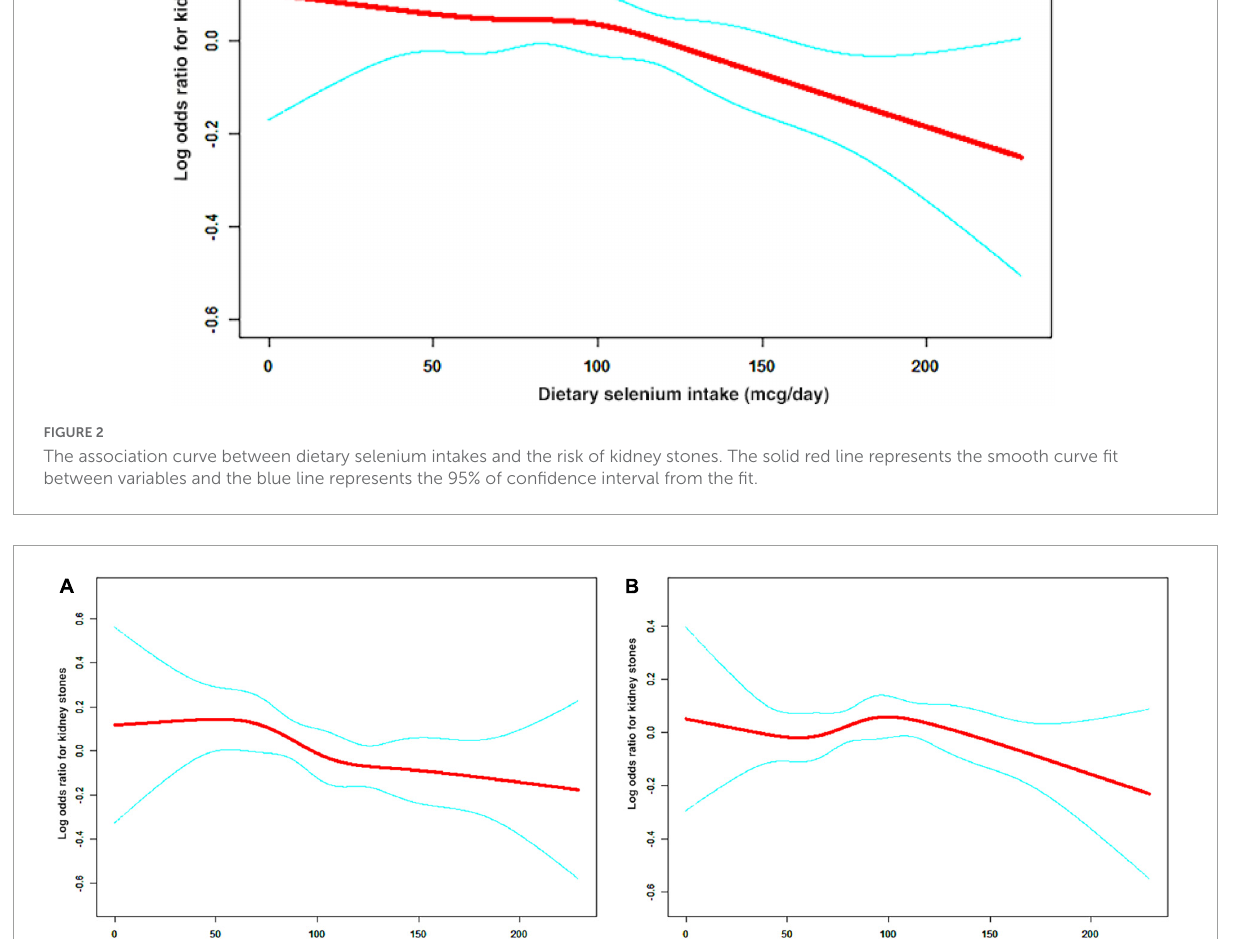
statistical differences between Q4 and Q1 for individuals with a BMI ≥ 25.0 in Model 1 (OR 0.88, 95% CI 0.77–0.99, P <